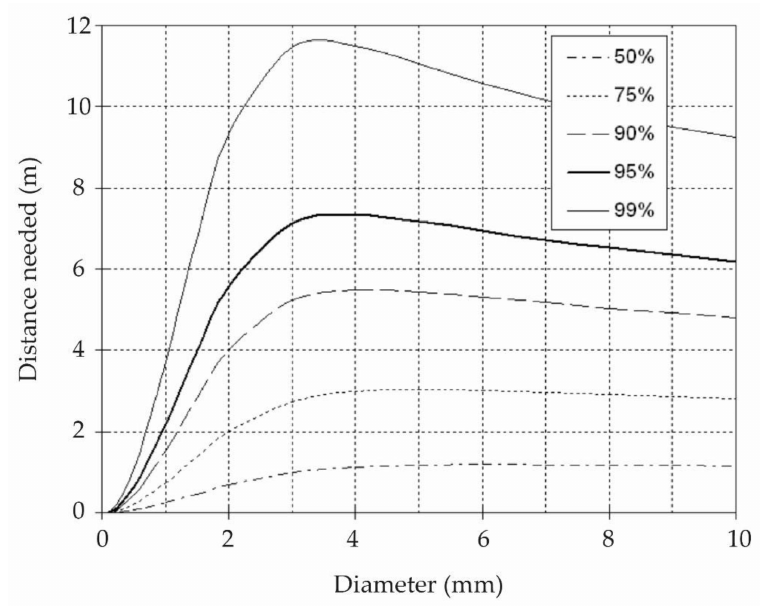
Figure 1. Graph showing the distance needed by raindrops to obtain the indicated percentage of their terminal velocity as a function of their diameter (taken from Van Boxel research [30]).